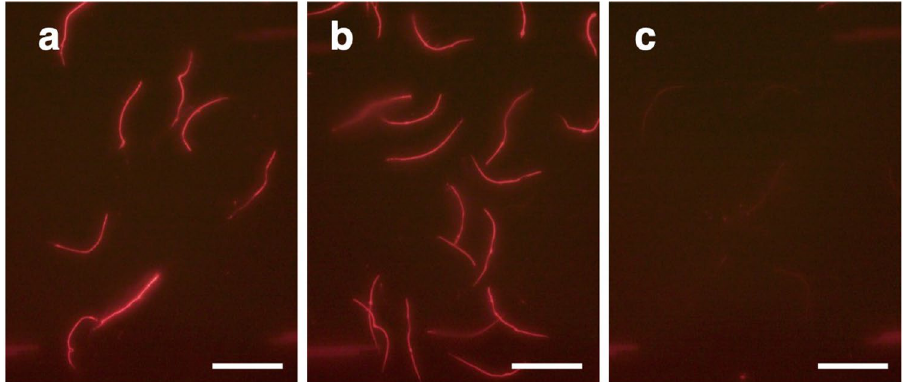
Figure 5. Mitochondrial membrane potential of sperm in ( a ) aerobic PBS control, ( b ) anoxic PBS (after adding sodium sulfite), and ( c ) aerobic PBS containing buffer FCCP as negative control. Scale bars indicate 50